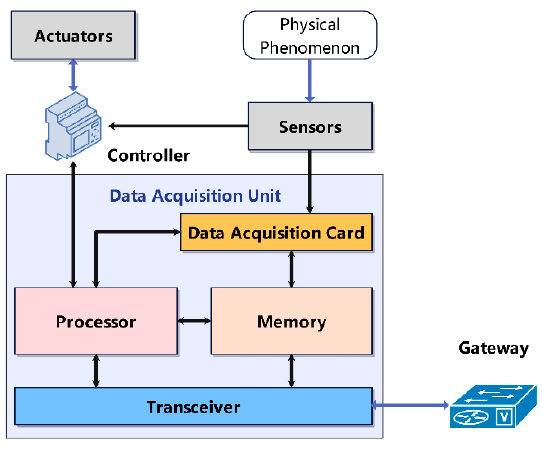
Figure 2. Wired data acquisition devices.